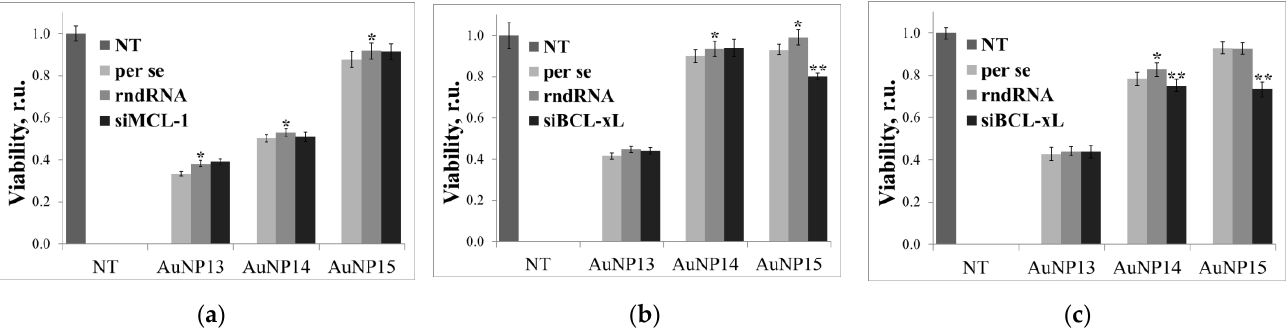
Figure 4. Dose-response curves of ( a ) HeLa, ( b ) HL-60, and ( c ) CEM-SS after 72 h incubation in AuNP. Data obtained from MTT assay normalized to control (untreated) cells.